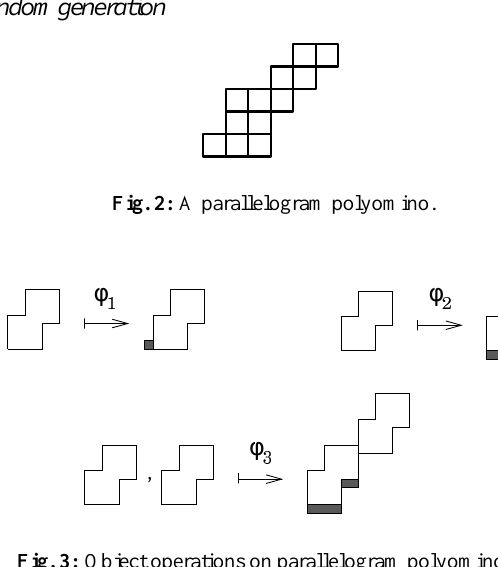
Fig. 3: Object operations on parallelogram